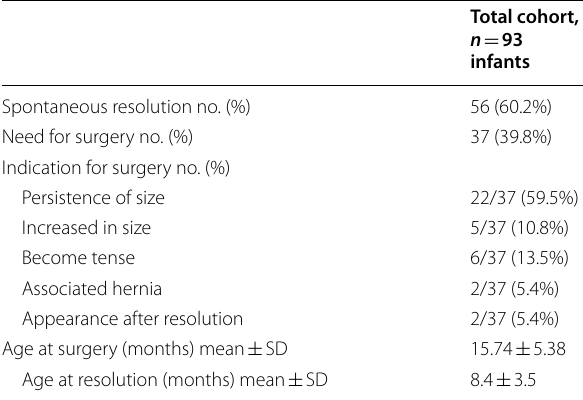
Table 2 Outcome of 18 months of watchfulness and surgery